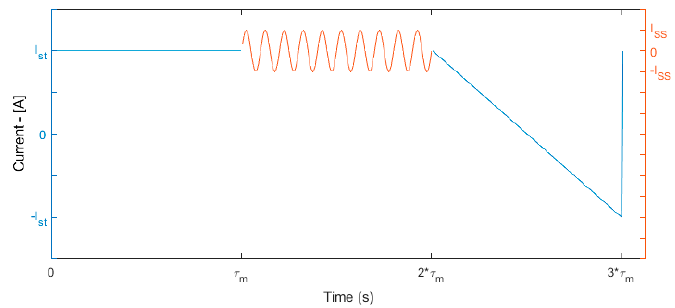
Figure 6. Measurement procedure signal time pattern.